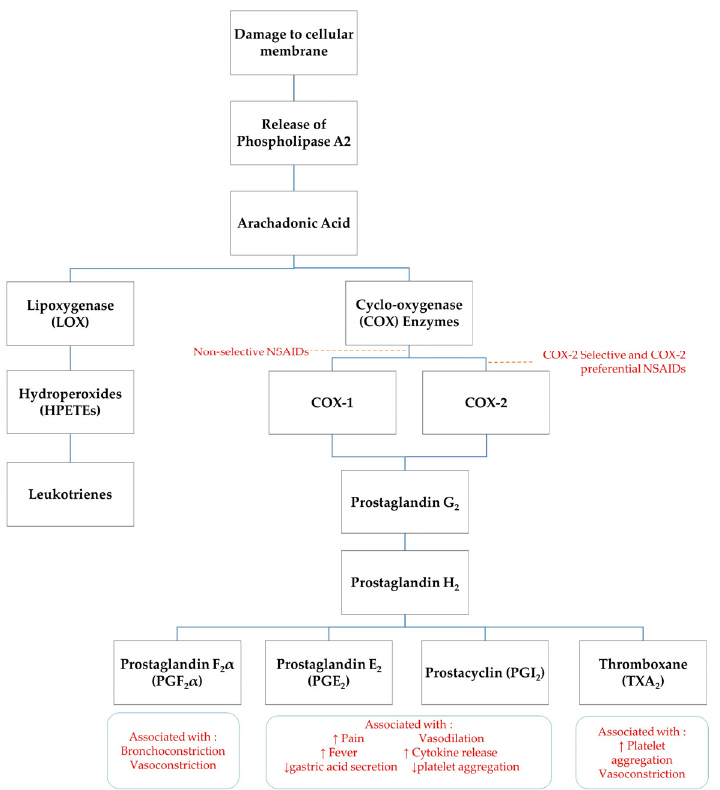
Figure 1. Schematic of arachidonic acid cascade. ↑ indicates increase, ↓ indicates decrease.